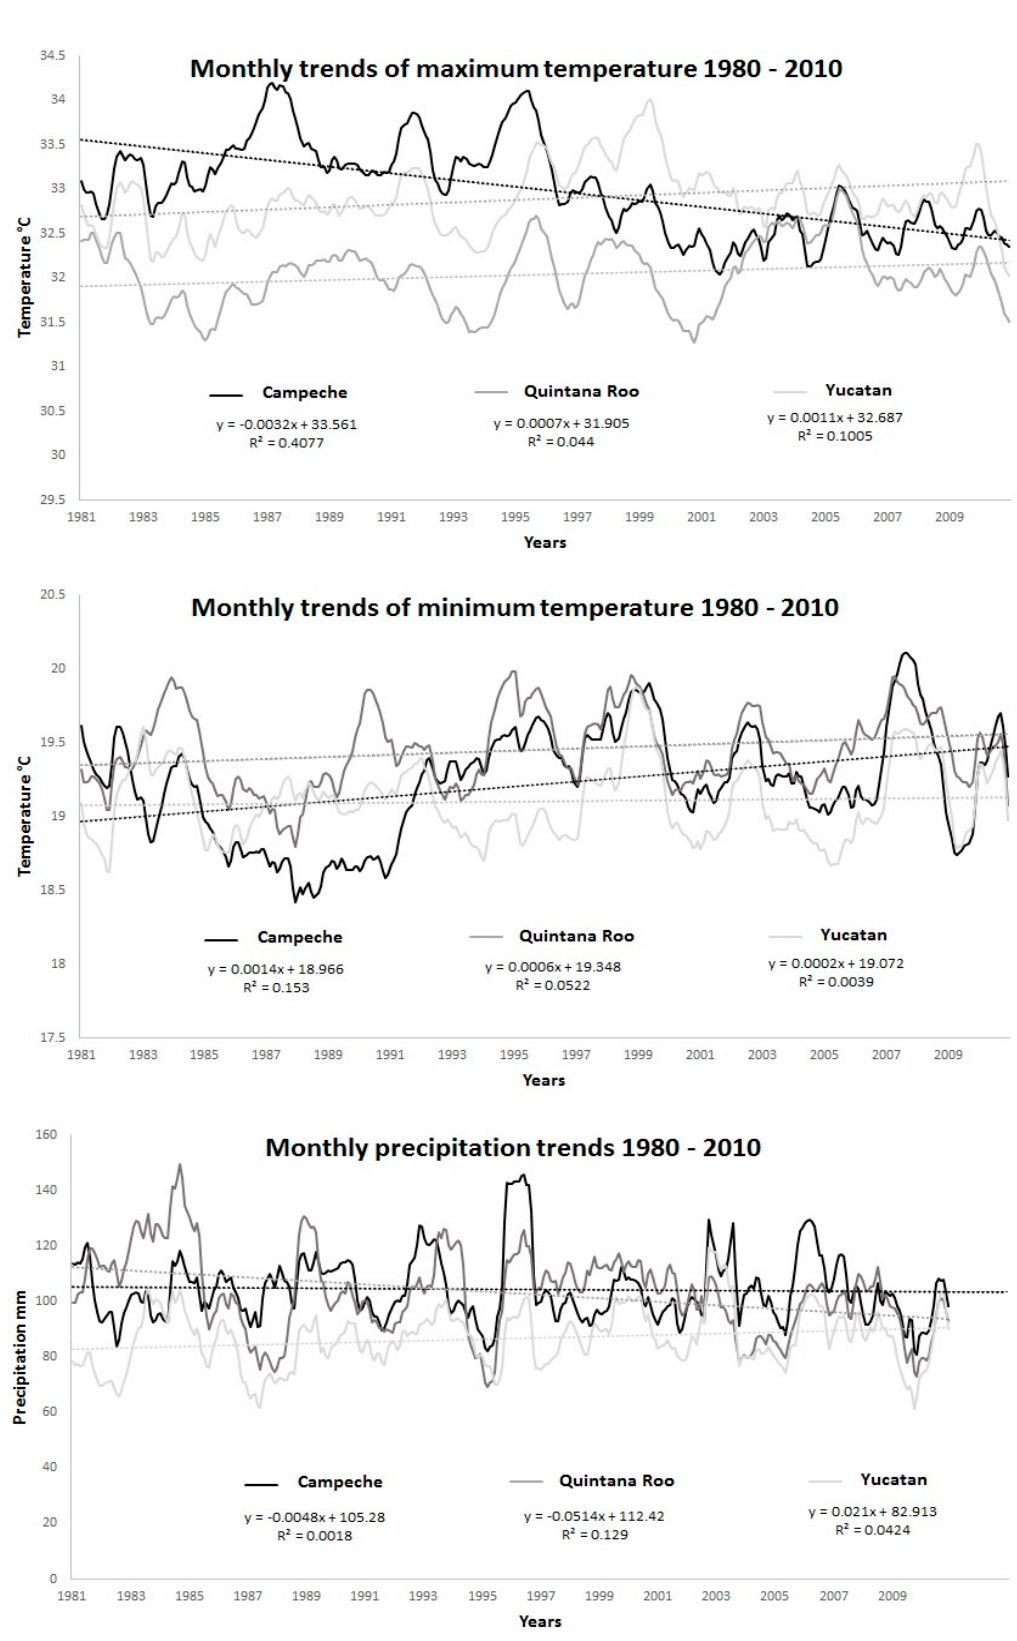
Figure 3. Trends for maximum temperature, minimum temperature, and precipitation for each state, from 1981 to 2010.